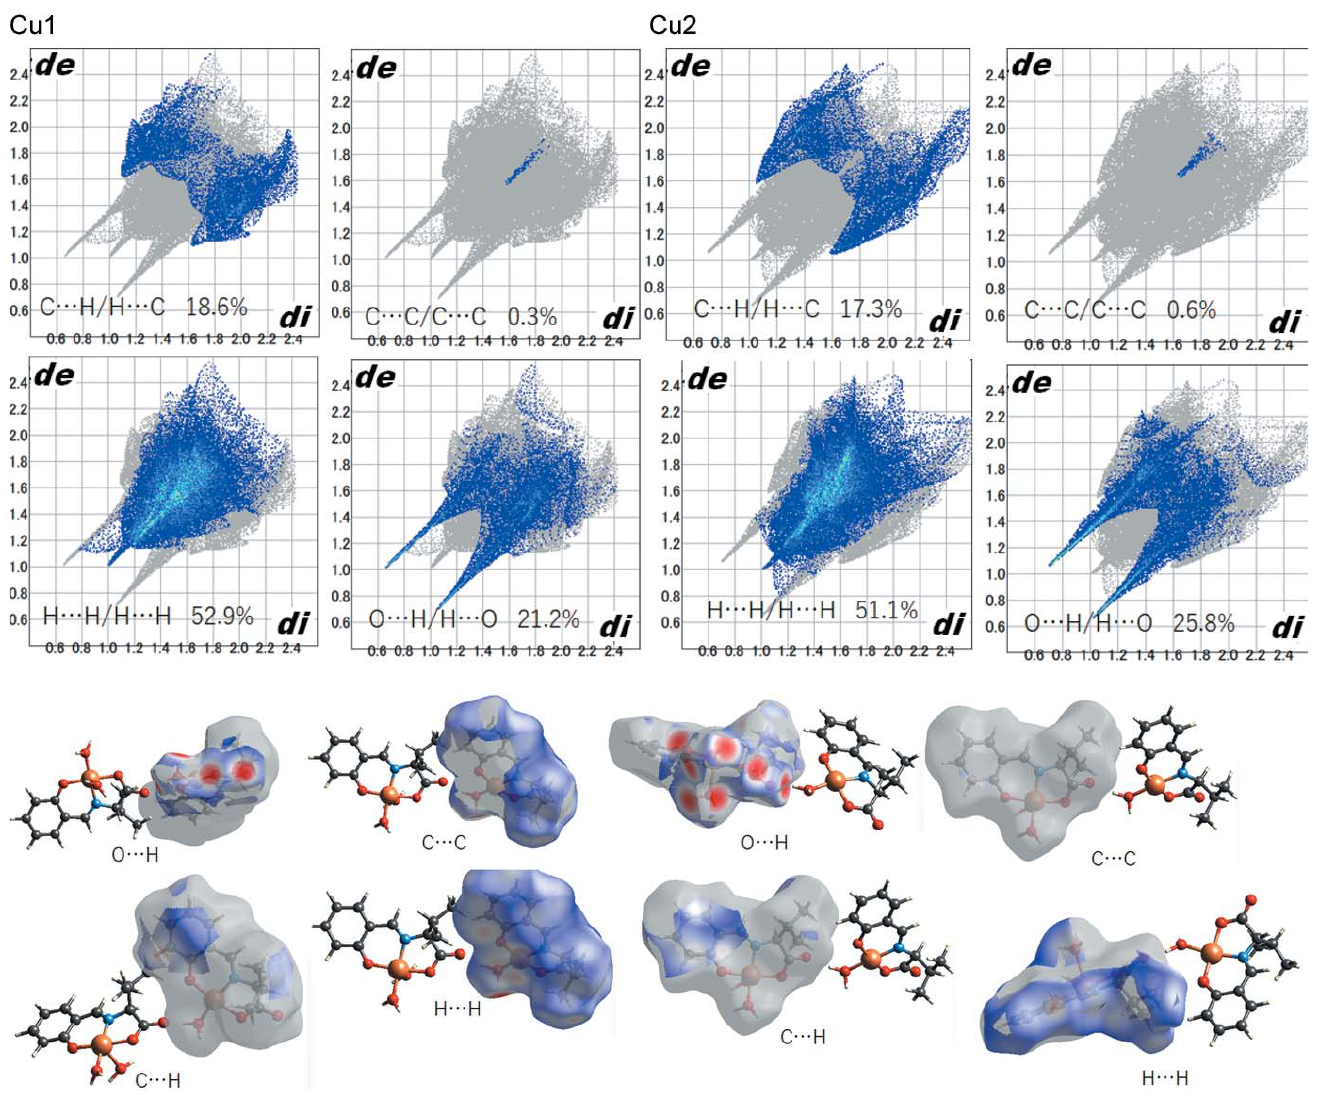
Figure 4 Hirshfeld surfaces mapped over d norm and two-dimensional fingerprint